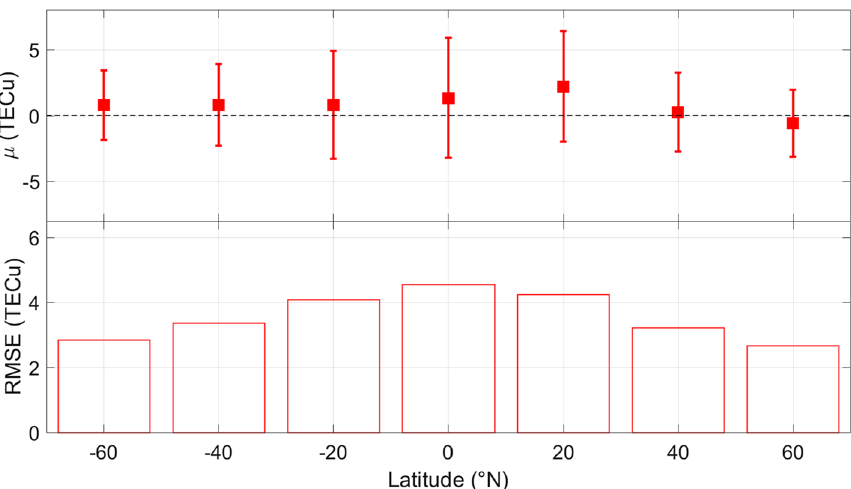
Fig. 16. Latitudinal dependence of bias (red square, top panel), standard deviation (error bars, top panel) and RMSE (bottom panel) of vTEC from JASON-3 vs. vTEC from